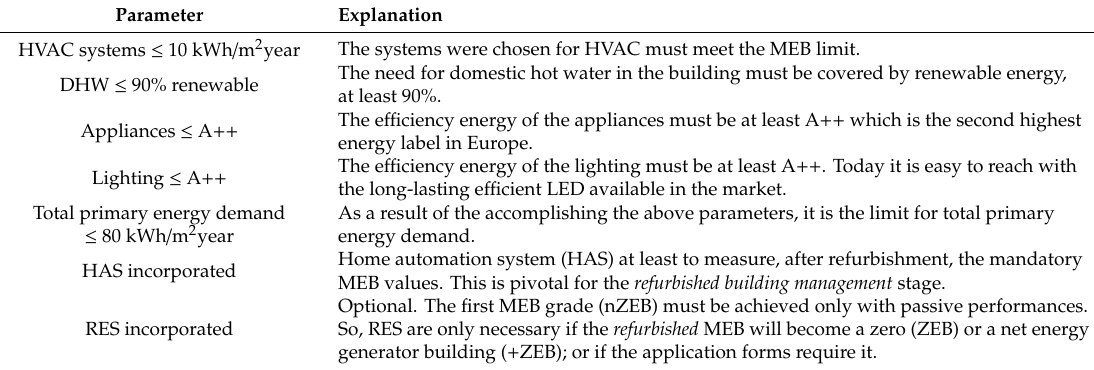
Table 3. MEB facilities and systems engineering retrofitting design